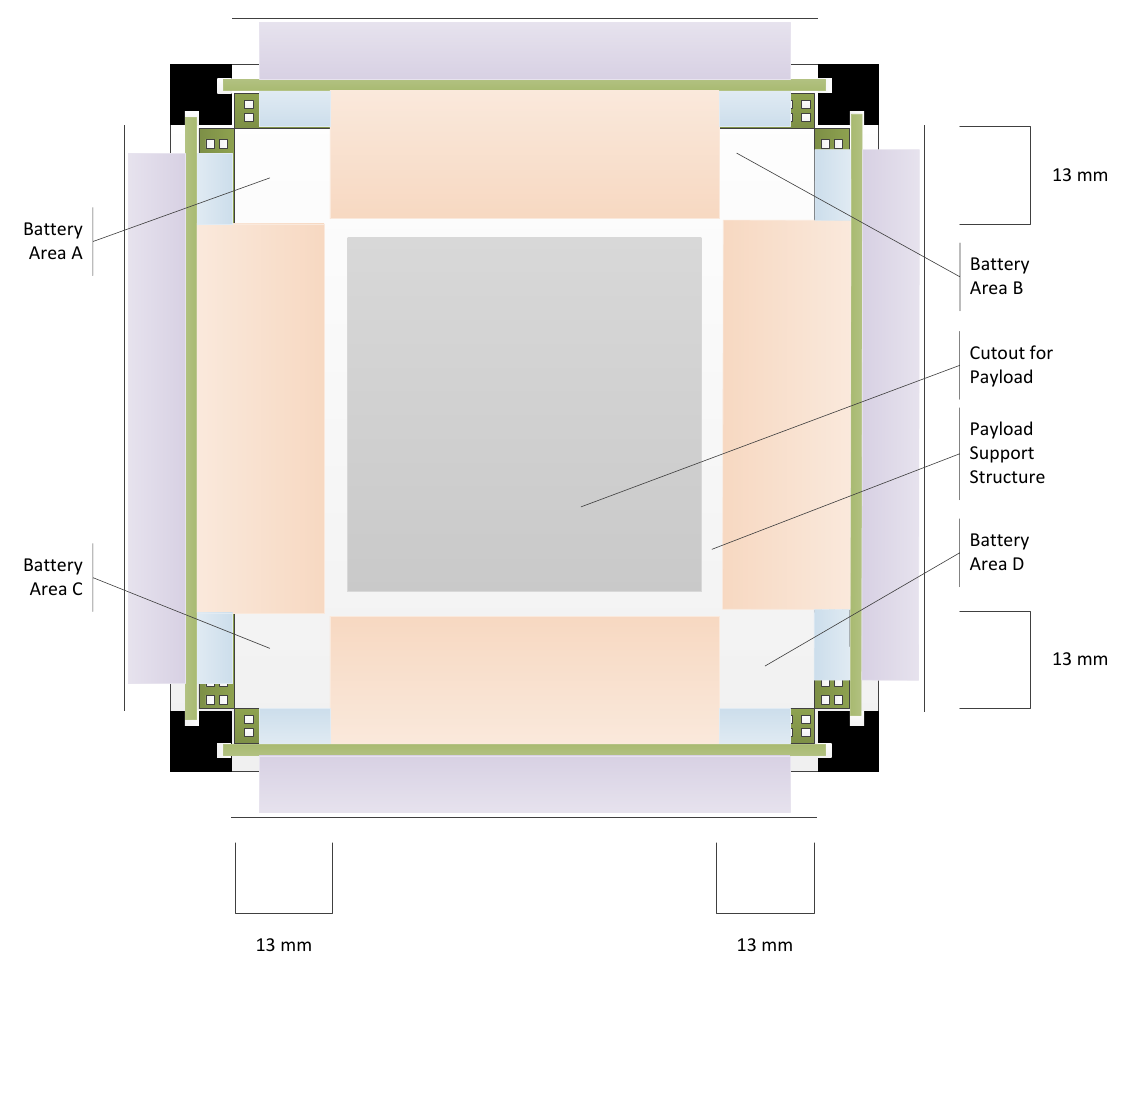
Figure 17. Overlay of Board Clearance Diagram on combined corner post/receiver and base plate